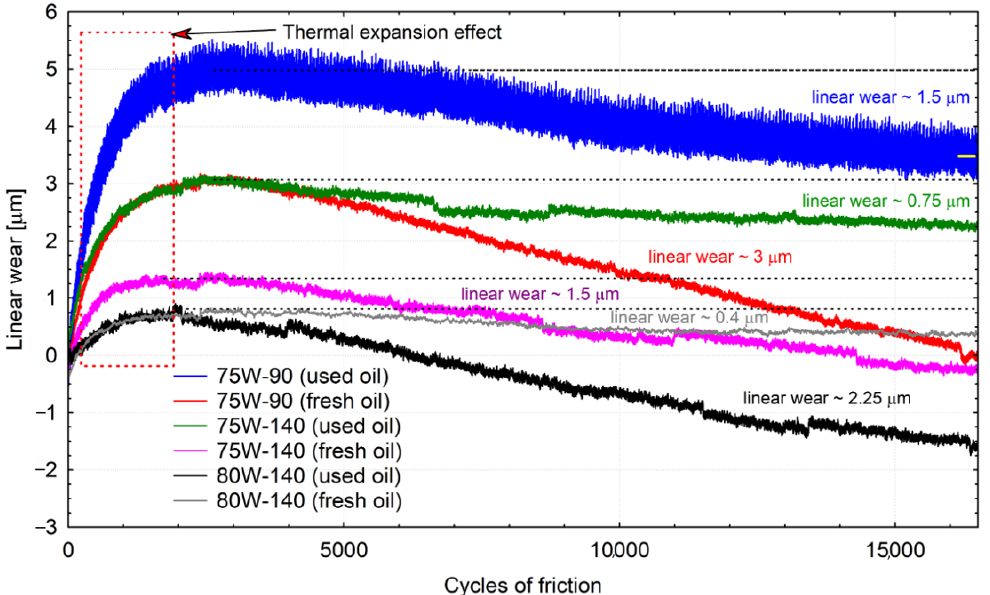
Figure 7. Linear wear of friction pairs in oil bath.